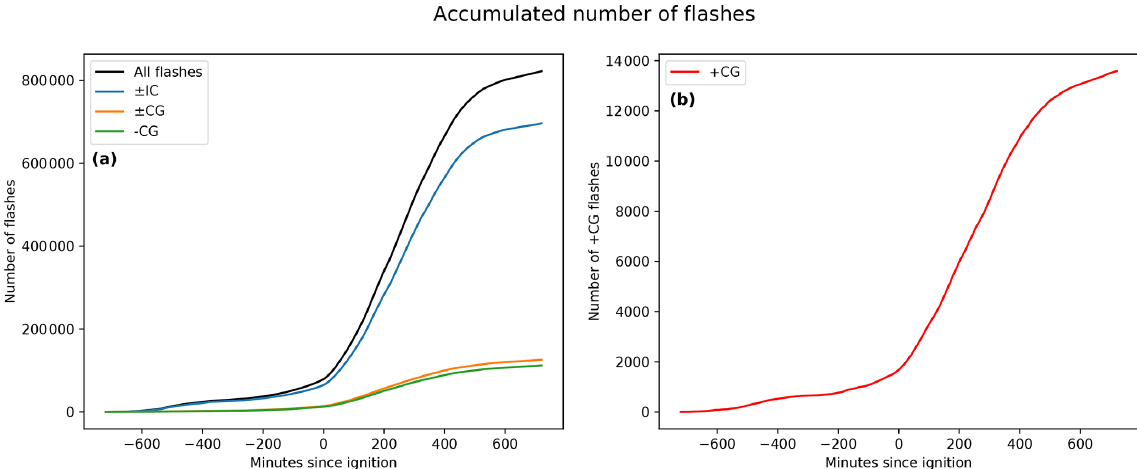
Figure 14. Cumulative number of flashes occurring in 77 fire-igniting thunderstorms over the Iberian Peninsula during 1400min around the ignition of a lightning-ignited fire. We plot all flashes, all IC flashes ( ± IC), all CG flashes ( ± CG), and − CG flashes in panel (a) . We plot + CG flashes in panel (b) .